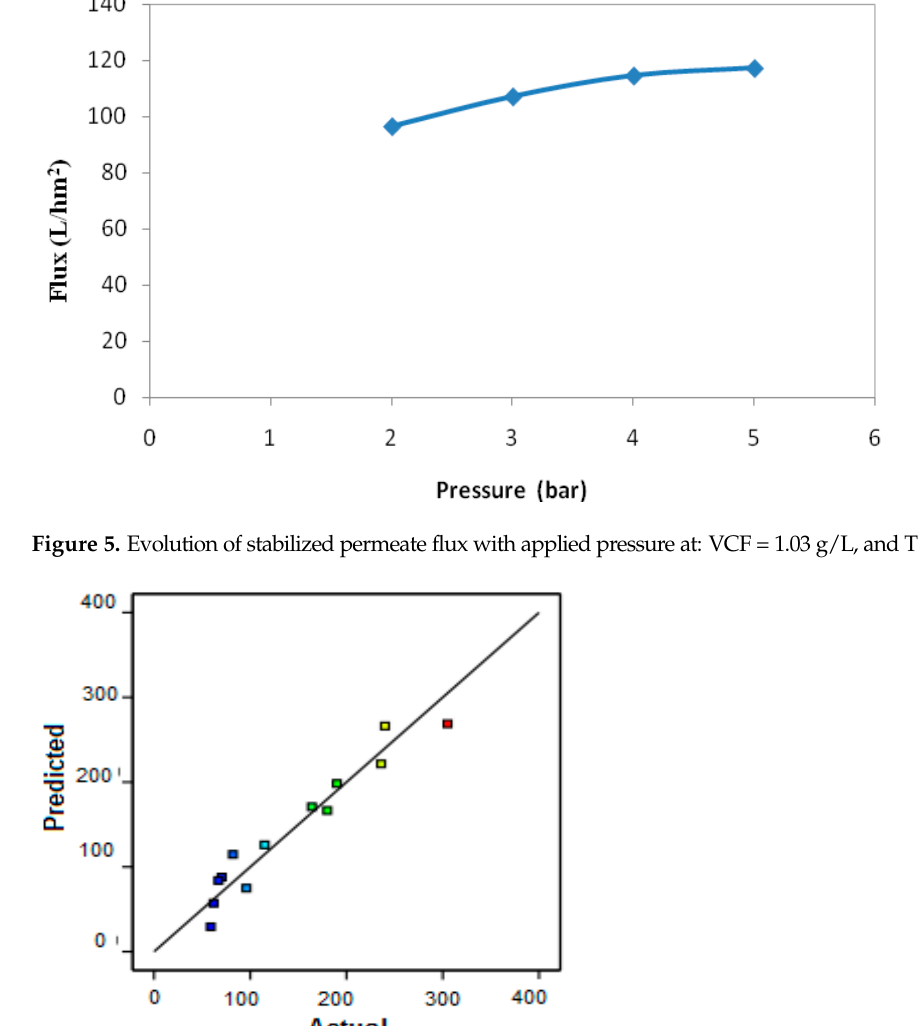
Figure 5. Evolution of stabilized permeate flux with applied pressure at: VCF = 1.03 g/L, and T = 20 °C.